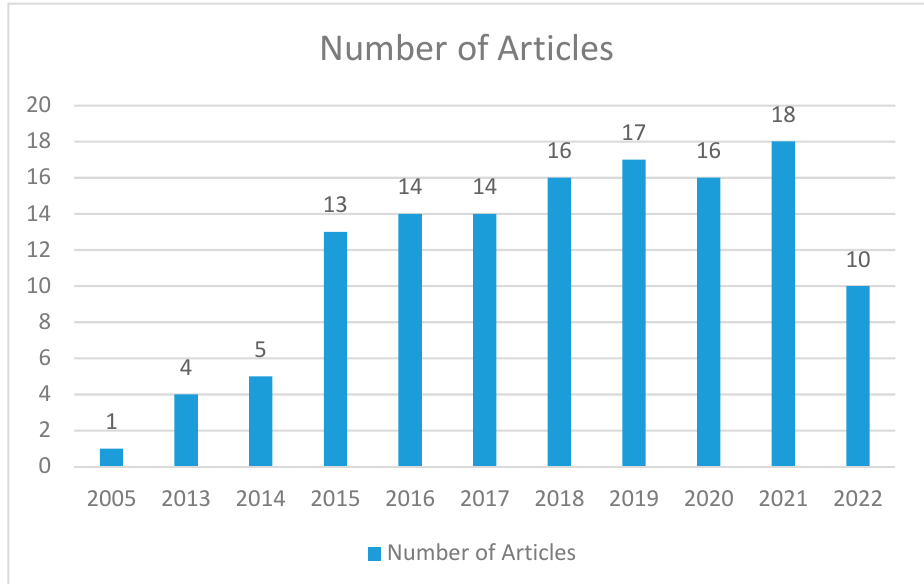
Figure 2. Number of articles published per